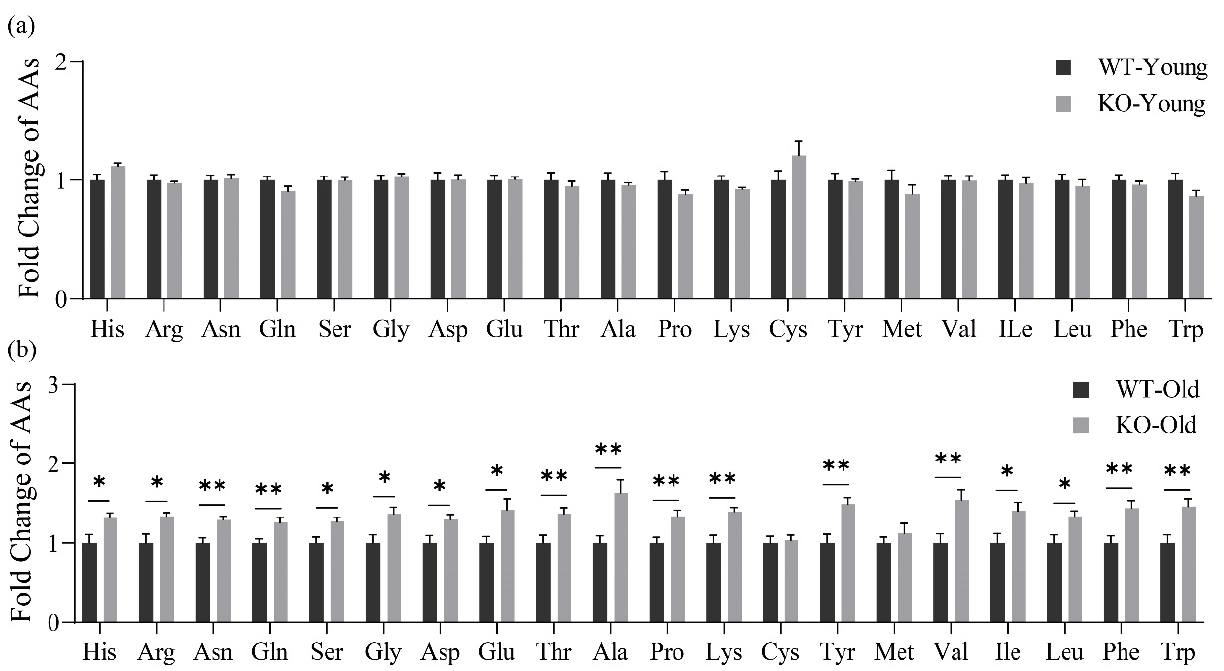
Figure 3. Effects of GPRC6A deletion on free amino acids in the urine of mice at different growth stages, ( a ) (8 weeks), ( b ) (55 weeks). All data were normalized by the average; error bars represent the standard error of the mean. The data were analyzed using an unpaired Student’s t -test, * p < 0.05, ** p < 0.01, n = 7–11.